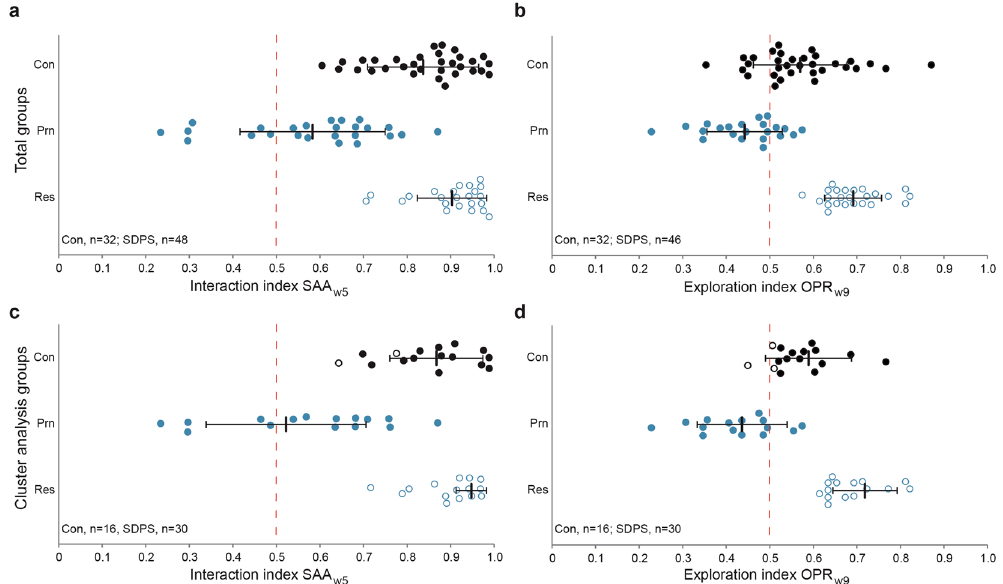
Figure 2. Cluster analysis: Individual variability in the effects of SDPS on the affective and cognitive domain. Two-step cluster analyses of social approach avoidance (SAA) and object place recognition (OPR) performance, each at weeks 5 and 9 post-defeat, revealed the emergence of two distinct SDPS groups, one displaying severely disrupted behaviour (SDPS-prone; Prn) and one exhibiting performance similar to controls (SDPS-resilient; Res). Individual performance at the SAA w5 ( a , c ) and OPR w9 ( b , d ) tests is depicted, as cluster analyses indicated these particular tests as the most important predictors of SDPS-vulnerability ( cf . Fig. 1). ( a , b ) Individual performance at SAA ( a ) and OPR performance ( b ) on the total set of SDPS rats (n = 46–48), and the total set of control (Con) rats (n = 32) for comparison. ( c,d ), Individual performance of control (Con) rats (n = 16) and SDPS rats showing overlap in SAA and OPR after cluster analysis (see ( a , b ); n = 30; n = 15 per subgroup) at the SAA ( c ) and OPR ( d ) tasks. SDPS-resilient rats clustered together with all but two control rats at the SAA task ( c ), and all but three control rats at the OPR task ( d ), which are indicated by open circles. All panels: Group mean and standard deviation (vertical line with horizontal whiskers); red dashed line indicates interaction ( a , c ) or exploration ( b , d ) indices at chance level